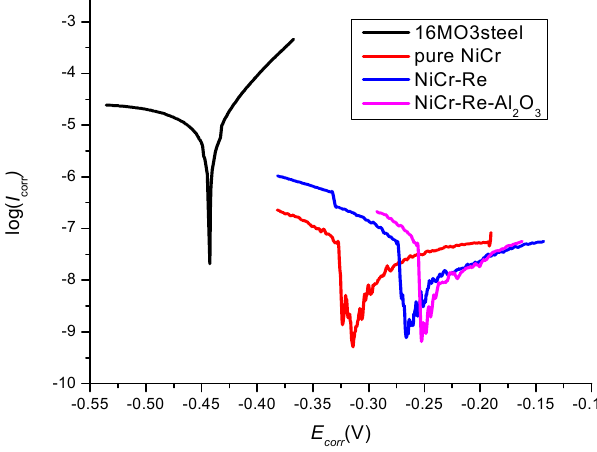
-0.55 -0.50 -0.45 -0.40 -0.35 -0.30 -0.25 -0.20 -0.15